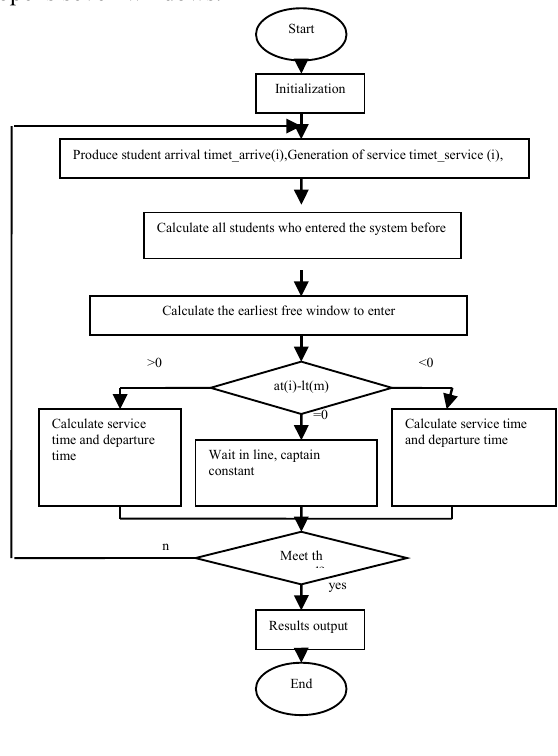
Fig. 2. Flow chart of canteen queuing simulation.